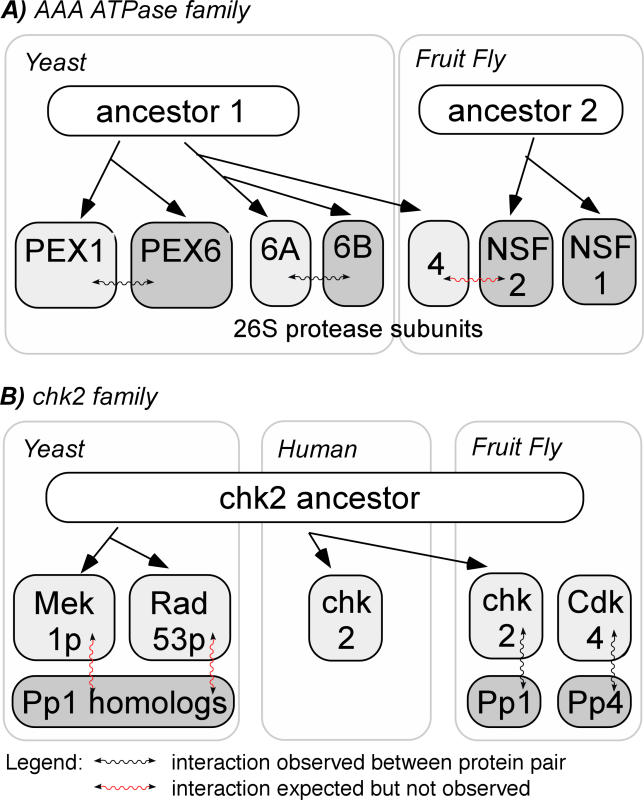
Interspecies Failure and Intraspecies Success of Homology Transfer(A) Same family, different ancestors, different PPI: Two yeast peroxisomal proteins (PEX1 and PEX2) are closely related through their common ancestor protein and their function as AAA ATPases to the two yeast 26S protease regulatory subunits 6A and 6B. In the fruit fly, gene duplication of a second ancestor protein (the NSF ancestor) led to two distinct NSF proteins (NSF1 and 2). Since the ancestors for the NSFs (NSF1 and 2) and for the 26S protease subunits were two different proteins, we conclude that despite their common biochemical function as ATPases, the different cellular functions of NSFs and 26S protease subunits also led to a distinct behavior with respect to protein–protein interactions. Therefore, neither NSF1 nor NSF2 were observed to bind to the 26S protease subunit 4.(B) Same pathway, different functions, different binding: Evolutionary plasticity in the chk2 family led to a diverse range of functions of these proteins while staying in the same pathway. For example Rad53p in yeast is a main player in the cell cycle checkpoint during mitosis, whereas Mek1p acts in the same position during meiosis. Also, drosophila chk2 and human chk2 act at different times during the cell cycle different from Mek1p and Rad53p. No drosophila Pp1 homolog in yeast was found to interact with either Mek1p or Rad53p, even though drosophila Pp1 was shown to bind to drosophila chk2.